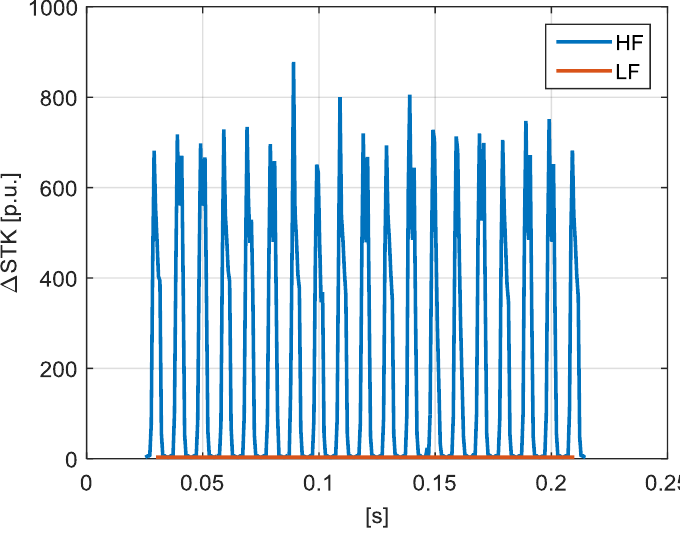
Figure 6. Case study 1: Δ STK at low-frequency (0 ÷ 2 kHz, red line) and at high-frequency (2 ÷ 150 kHz, blue line) obtained by the instantaneous approach.